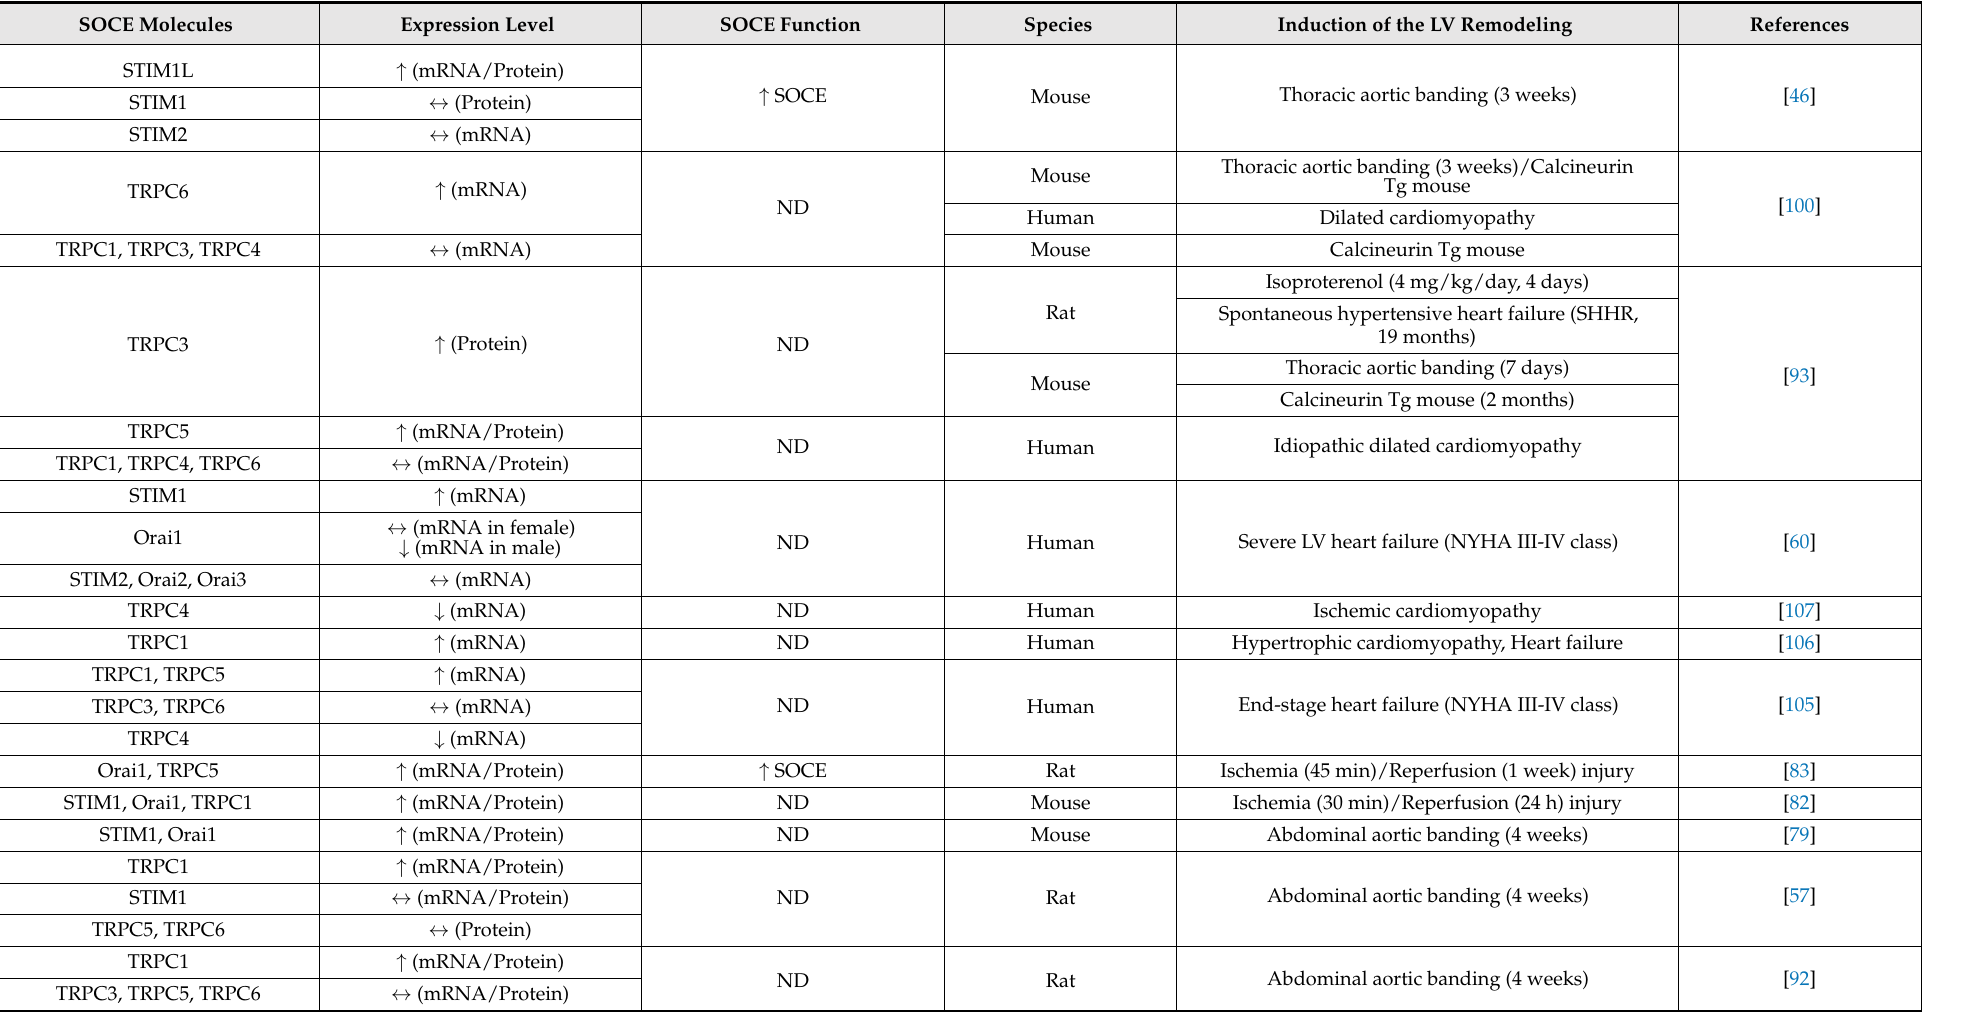
Table 1. SOCE Molecules Expression after Hypertrophic Stresses of the Left Ventricle. ↑ : increase; ↔ : no change: ↓ decrease; ND: not determined. SOCE